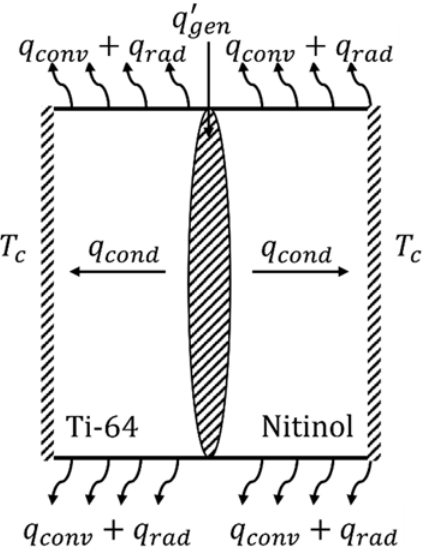
Figure 8. Heat transfer paths of the LW specimen.